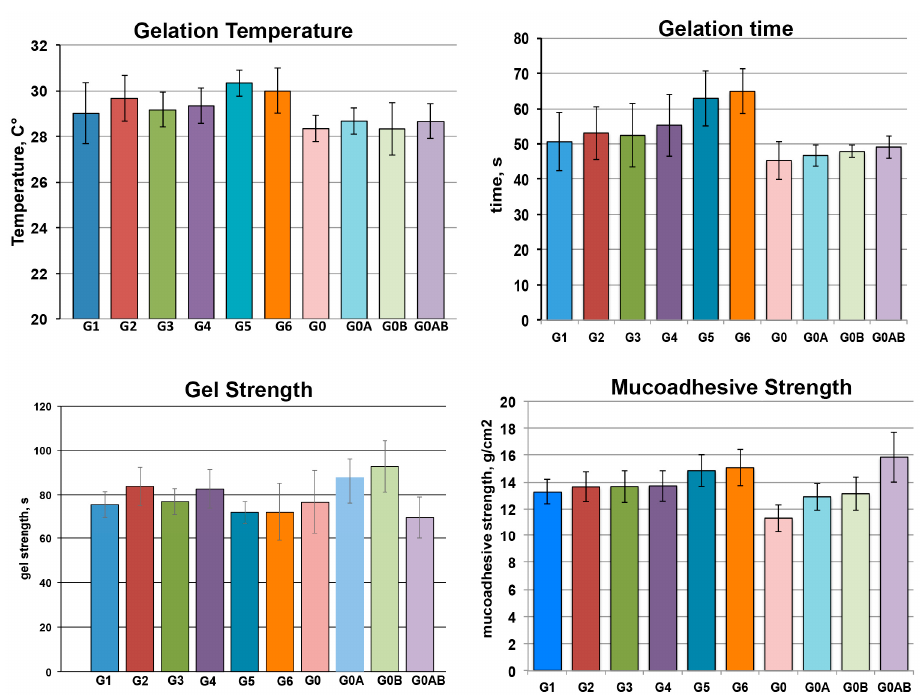
Figure 4. Gelation temperature, gelation time, gel strength and mucoadhesive strength of various thermosensitive mucoadhesive gel formulations (see Table 2 for gel compositions). Data are mean values ± standard deviation (s.d.) ( n = 3).